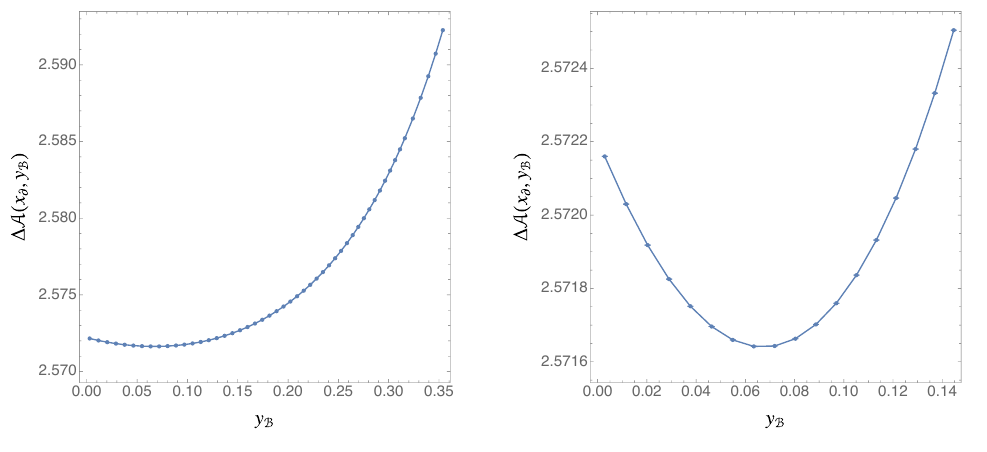
Figure 6: This figure depicts ∆ A ( x ∂ , y B ) as a function of y B , computed for x ∂ = 1 / 2 and θ = π/ 4. In the left panel we have y B ∈ [ 0.0028 ( 7 ) ,0.35379 ( 9 )] , whereas on the right we zoom in close to the point where the horizon intersects the brane. The surface corresponding to the minimum in this figure is the correct RT surface at late